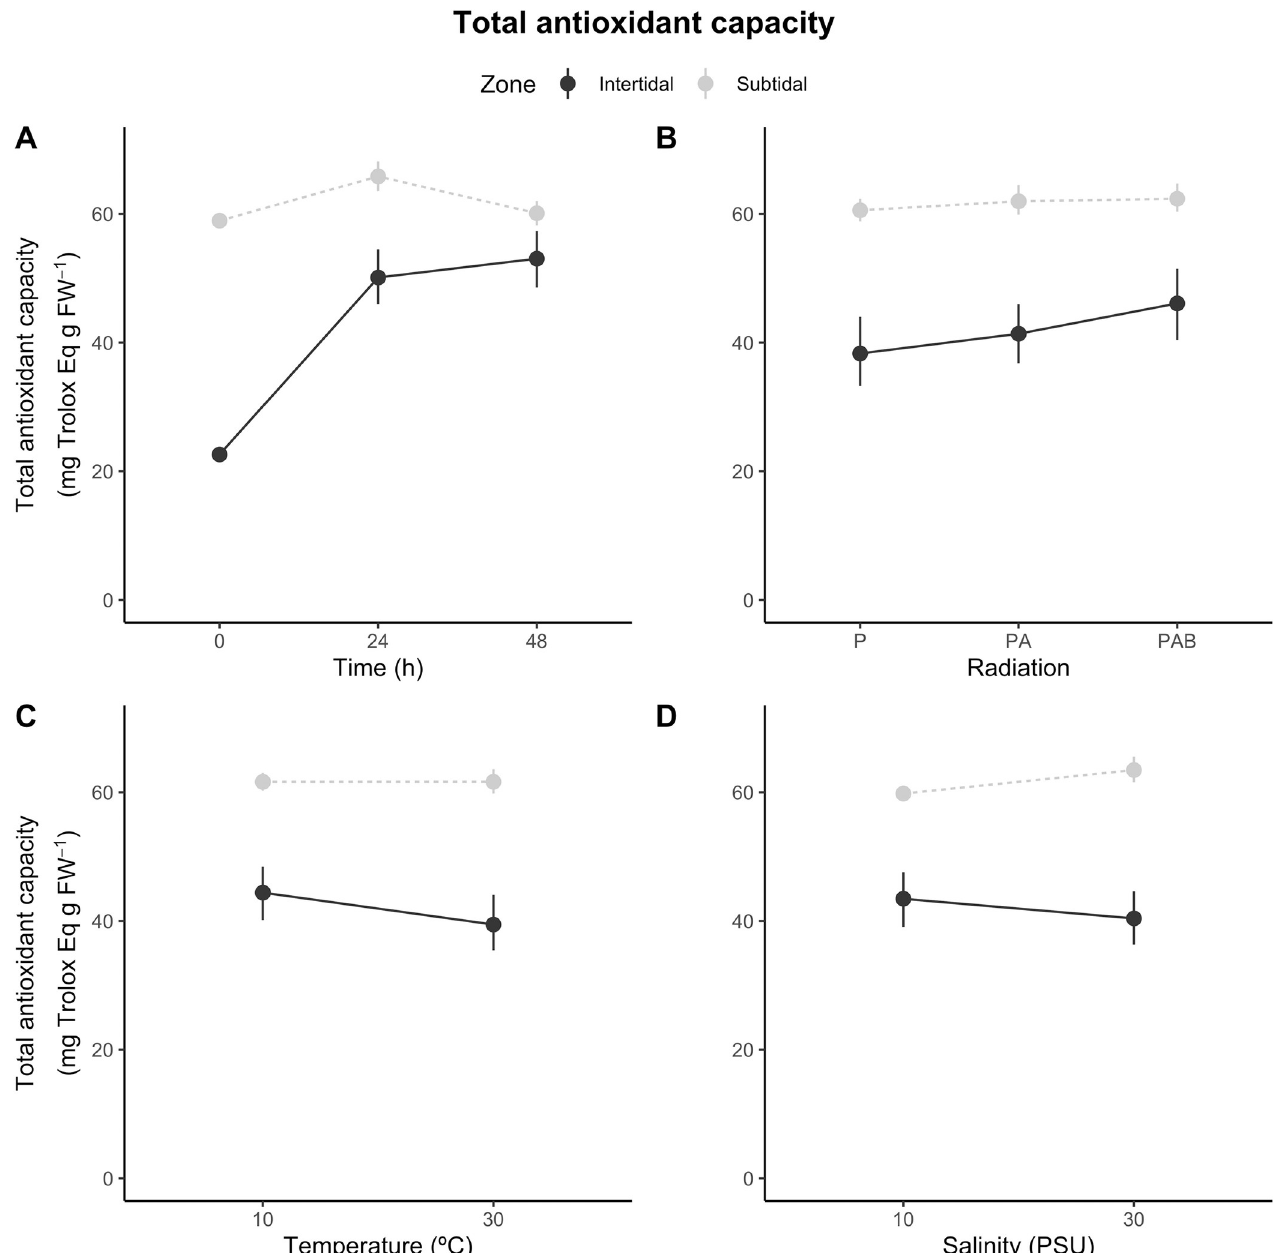
Fig 5. Anthopleura hermaphroditica . Total antioxidant capacity: zone-dependent responses of the estuarine anemone A . hermaphroditica to variations in (A) exposure time, (B) radiation treatment, (C) temperature and (D) salinity treatments. Values are provided as means ± confidence intervals (n = 4).